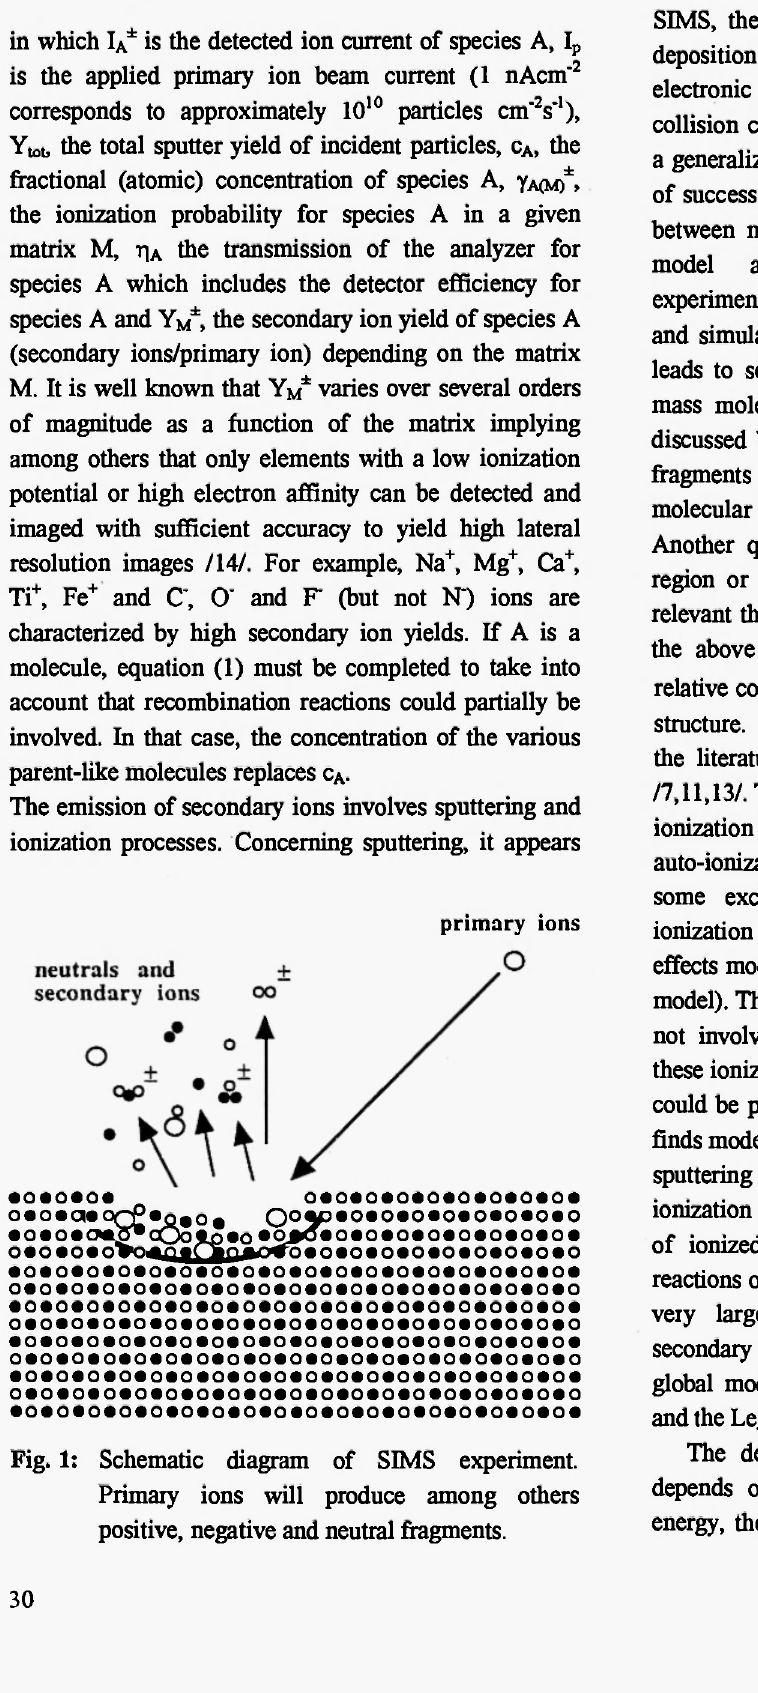
Fig. 1: Schematic diagram of SIMS experiment. Primary ions will produce among others positive, negative and neutral